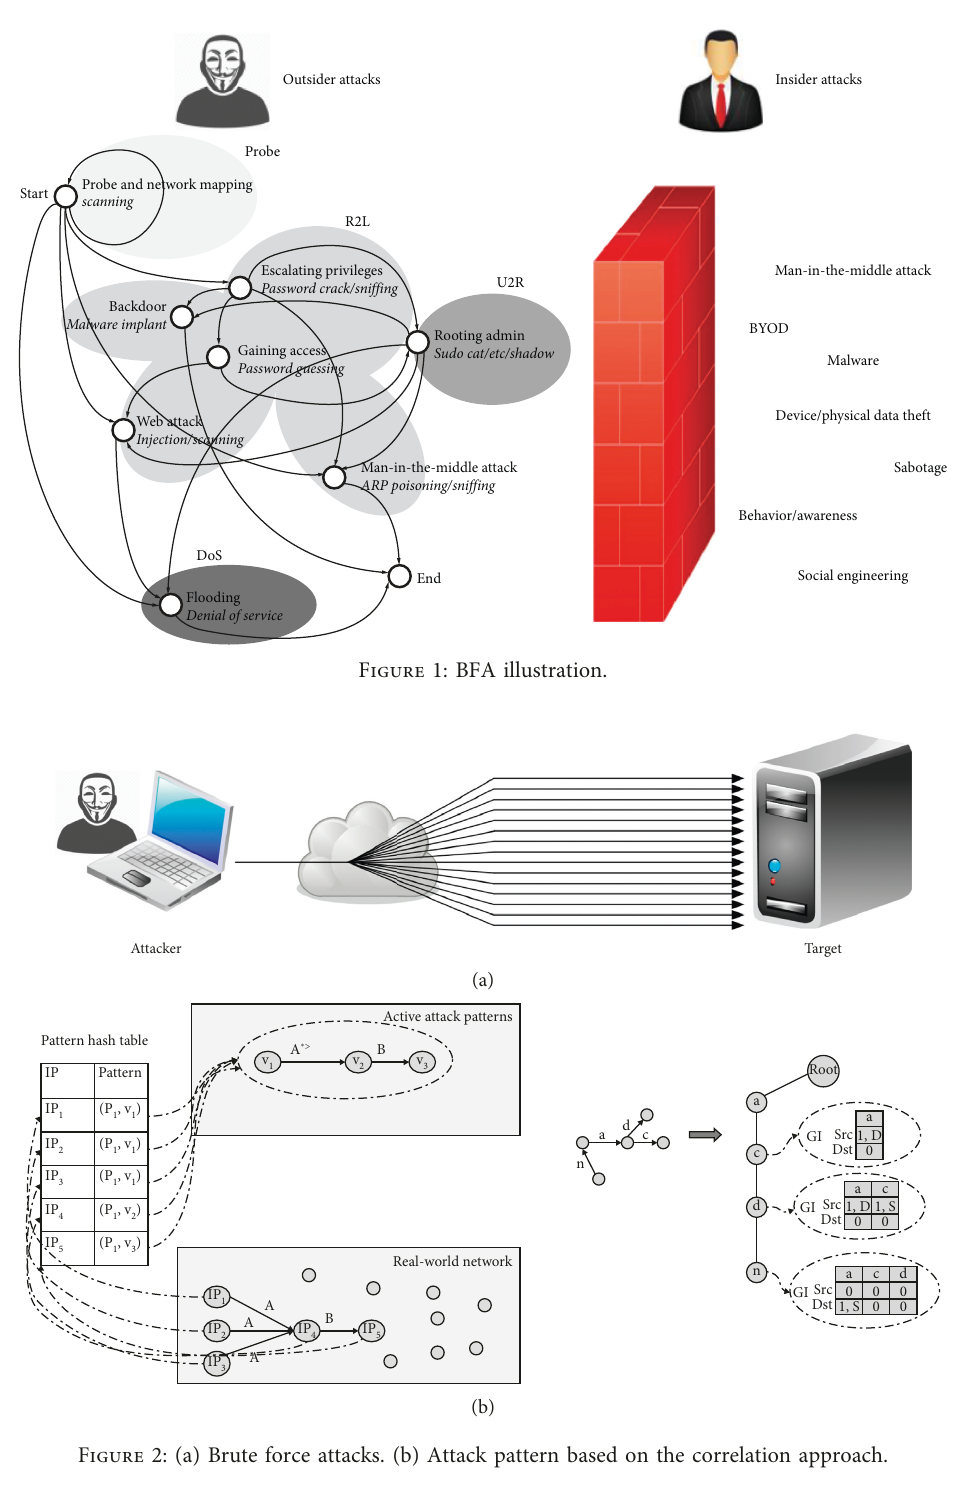
Figure 2: (a) Brute force attacks. (b) Attack pattern based on the correlation